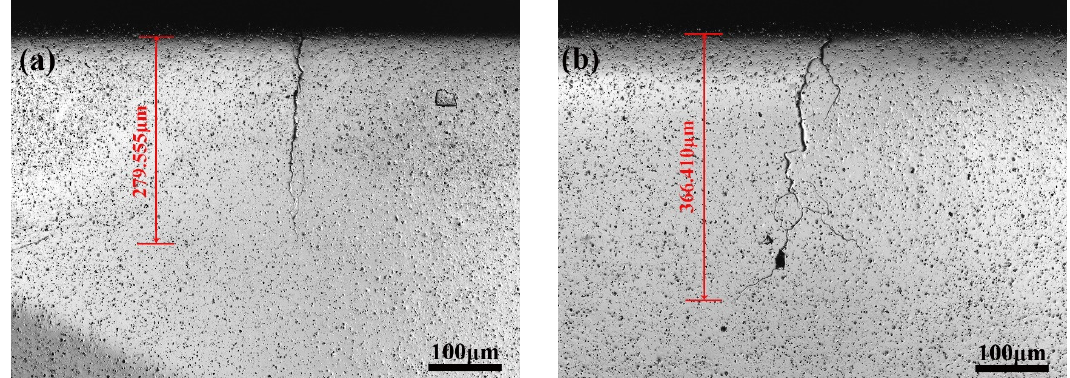
Figure 14. The 3D confocal microstructure of the TD–ND surface at the power density of 0.40 GW/m 2 : the rolled sample ( a ); fully recrystallized sample ( b ).